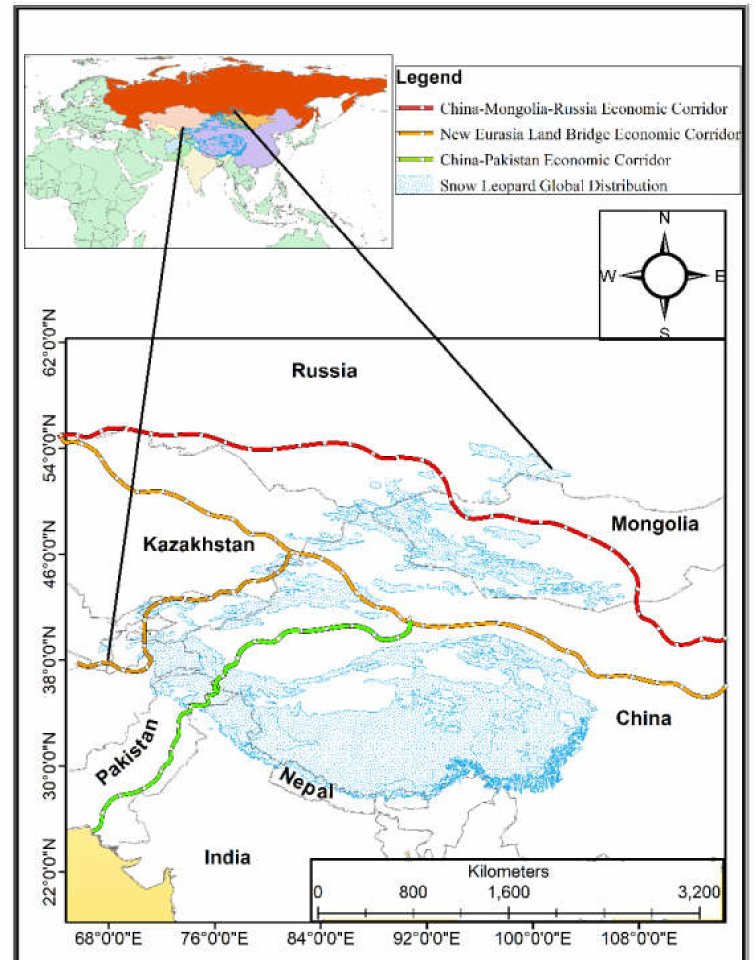
Figure 4. Identified Belt and Road Initiative (BRI) economic corridors are cutting through the snow leopard landscape in Asia resulting in increased